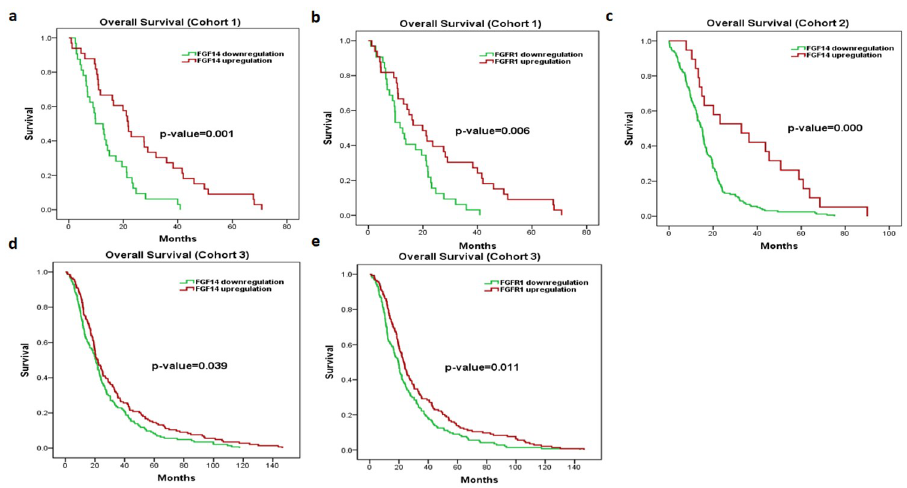
Fig 1. Kaplan–Meier survival analyses of FGF14 and FGFR1 in PDAC cohorts 1, 2 and 3. Red represents expression � the median, while green represents expression < the median. Overall survival plots of FGF14 ( a ), FGFR1 ( b ) in cohort 1. Overall survival plots of FGF14 ( c ) in cohort 2. Overall survival plots of FGF14 ( d ), FGFR1 ( e ) in cohort 3. ( � p � 0.05).